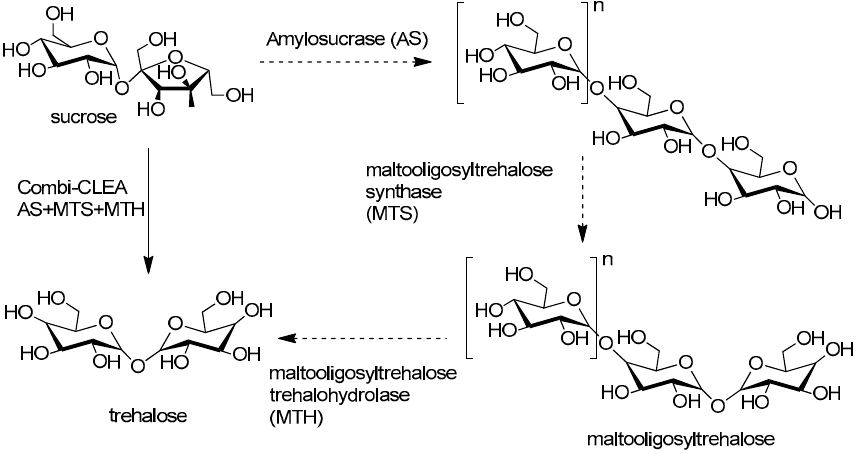
Figure 9. One-pot conversion of sucrose to trehalose with a combi-CLEA.